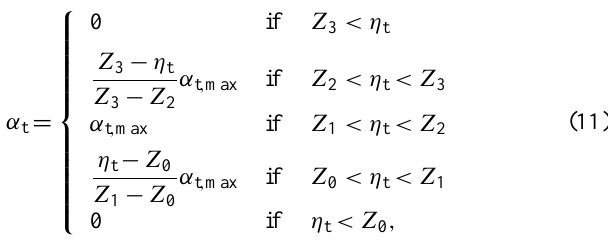
Figure 12. Parameters for the calculation of the tidal correction factor ( α t ), which depends on the tidal level ( η t ); the mean cross- shore span of the bars ( L ); the active depth ( h ∗ ); the surf-zone width ( X b ); and the level of the bar lower end ( Z 0 ), the bar upper end ( Z 2 ) and the levels Z 1 and Z 3 , which vary with the wave height ( H rms ).